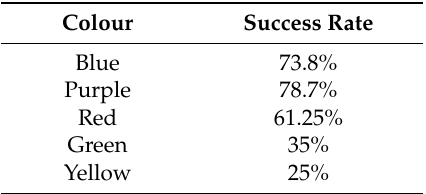
Table 2. Object colour versus the tracking success